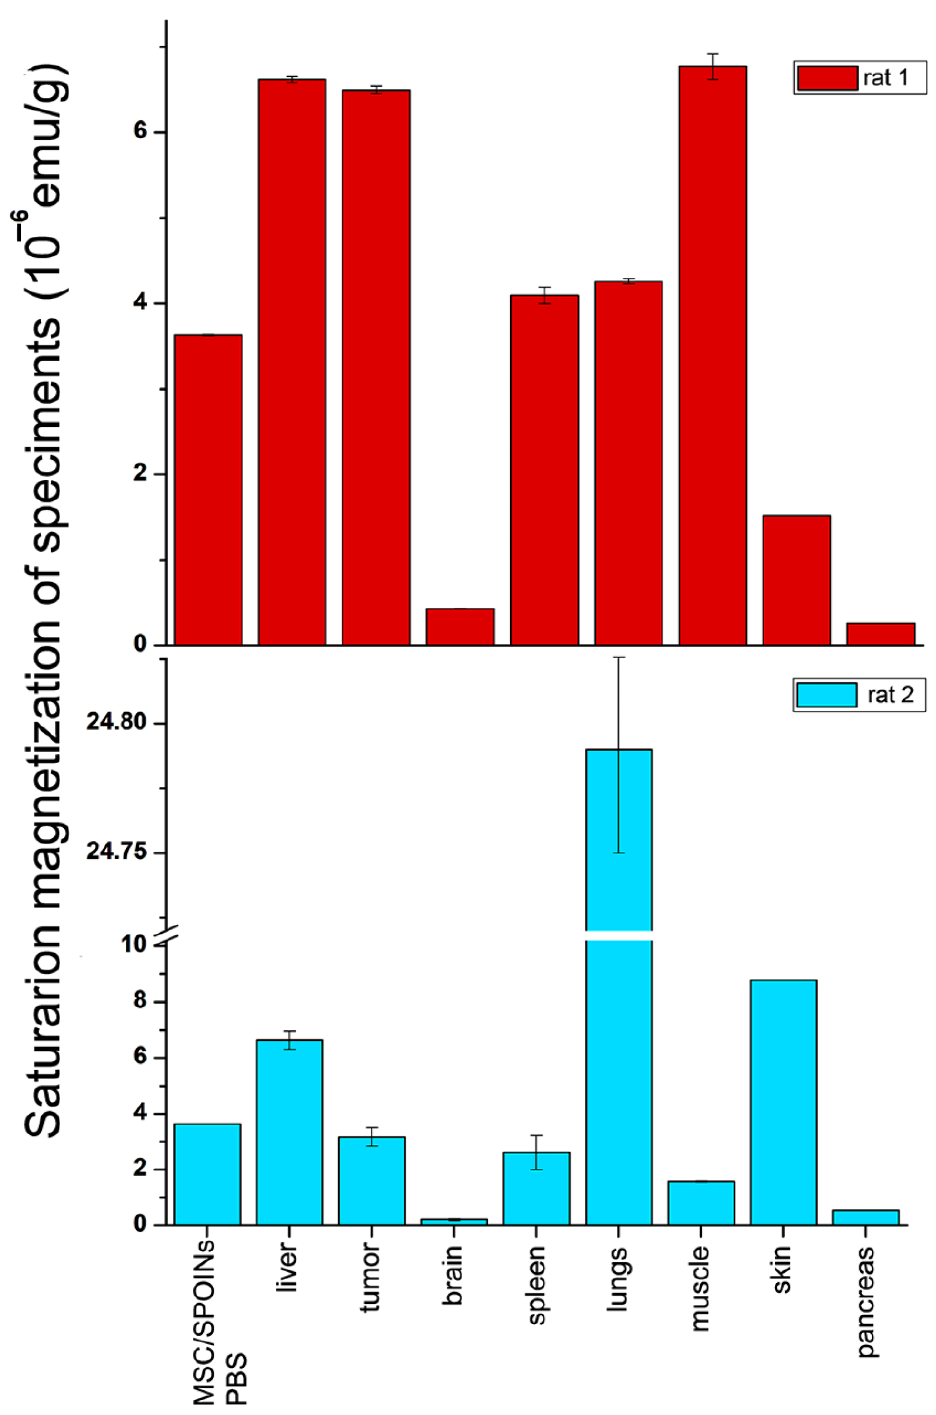
Figure 6. Representative diagrams of biodistribution of the SPIONs-labeled rat MSCs in tissues of experimental and control experimental and control animals.